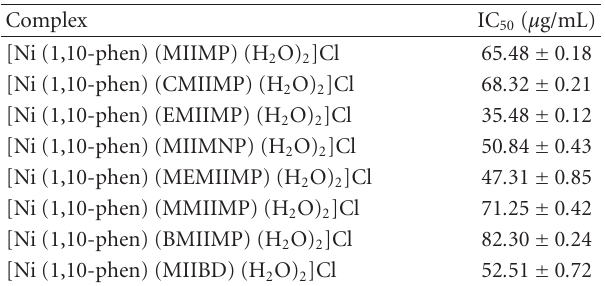
Table 5: IC 50 range of Ni(II) complexes for HeLa